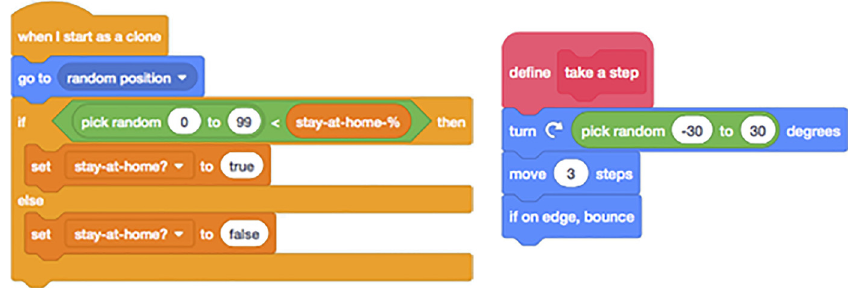
Figure 6. Initialization of the parameters in simulation 1